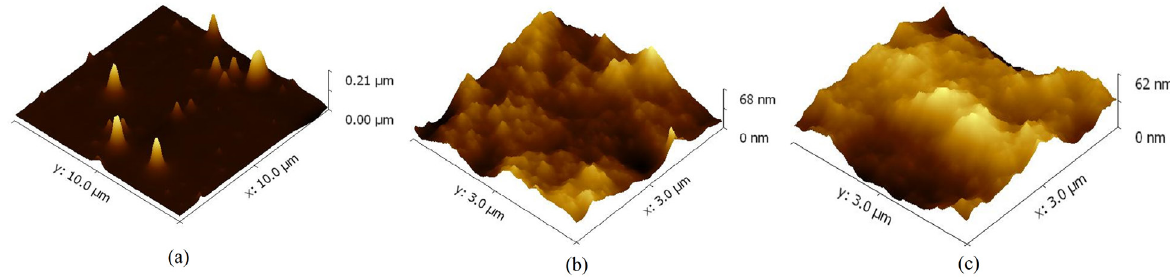
Figure 6: Three-dimensional images (3D-AFM) in case of thin layers obtained with PSSA-ANI at different molar ratios: (a) 1:1, (b) 2:1, and (c) 3:1